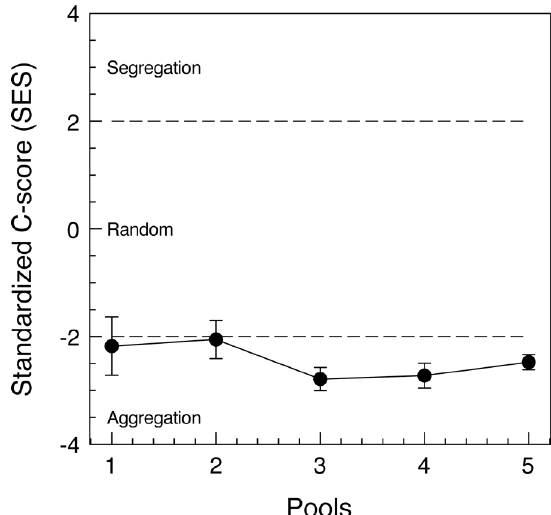
Figure 2. Level of organization (random, aggregation and segre- gation) of the taxa assemblages on leaf detritus in time given by the standardized C-score (SES ± SD sim